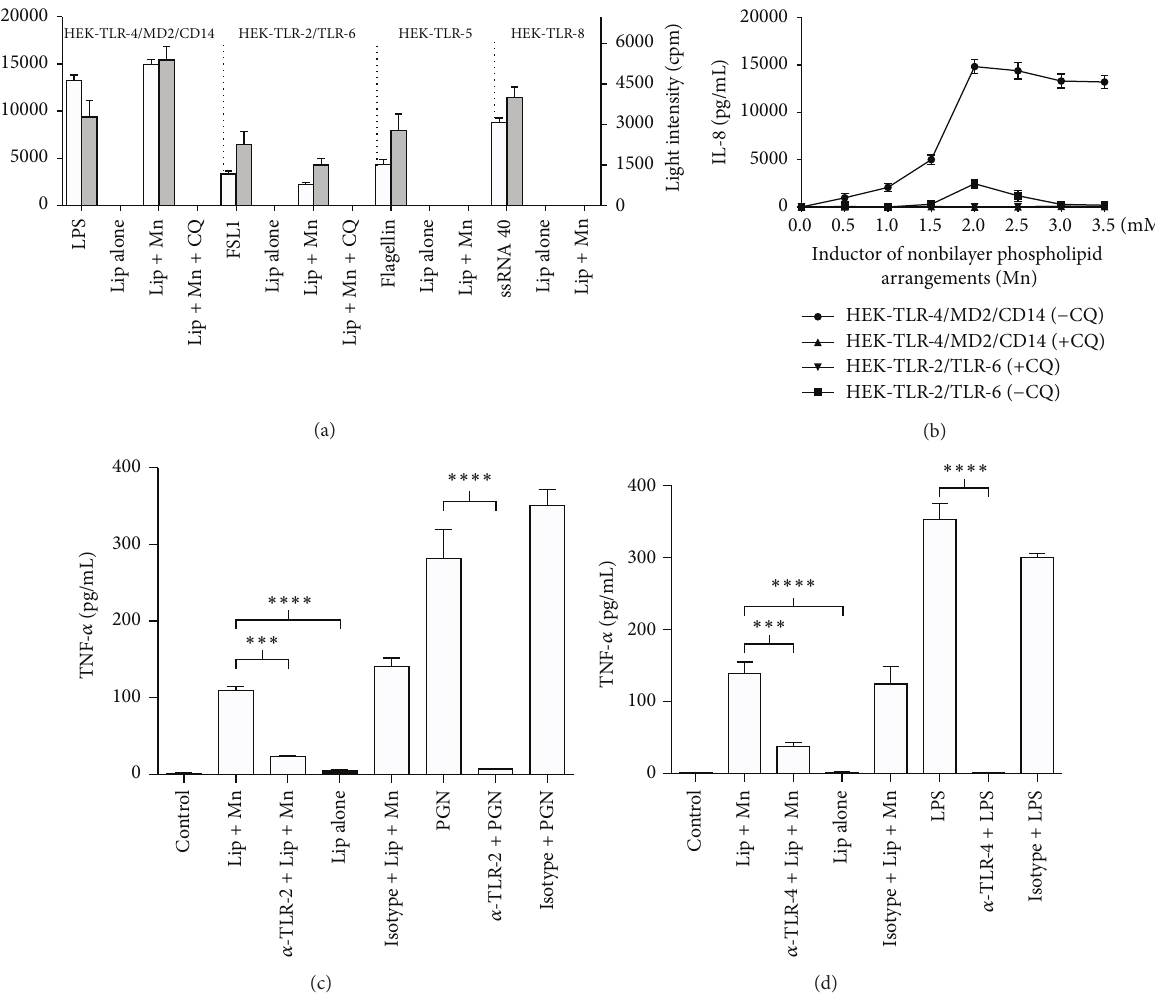
Figure 2: Liposomes with nonbilayer phospholipid arrangements induce TLR-2/6 and TLR-4 signaling in TLR-expressing HEK cells. (a) HEK-TLR-4/MD2/CD14, HEK-TLR-2/TLR-6, HEK-TLR-5, and HEK-TLR-8 cells were stimulated for 24h at 37 ∘ C with 10 𝜇 L of egg-yolk phosphatidylcholine/egg-yolk phosphatidic acid (2 :1) liposomes (50nmol phosphatidic acid in 50 𝜇 L TS buffer) alone or bearing nonbilayer phospholipid arrangements induced with 2mMMnCl 2 . As positive controls, cells were stimulated with their TLR agonist: 100ng/mL LPS, 1 𝜇 g/mL FSL1, 1 𝜇 g/mL bacterial flagellin, or2.5 𝜇 g/mLssRNA40, respectively. As negative controls, cells were stimulated with liposomes alone or bearing nonbilayer phospholipid arrangements + 0.1mM chloroquine (CQ). IL-8 levels and NF- 𝜅 B activation were measured 24h after stimulation. (b) HEK-TLR-4/MD2/CD14 and HEK-TLR-2/TLR-6 cells were stimulated with nonbilayer phospholipid arrangements induced with different MnCl 2 concentrations with (+CQ) or ( − CQ) 0.1mM chloroquine. IL-8 levels were measured 24h after stimulation. Histograms and graphs represent the mean ± SD of three independent experiments. (c, d) TLR-2 and TLR-4 of bone marrow-derived macrophages (BMDM) were analyzed. (c) 4 × 10 4 BMDM were stimulated with liposomes alone or bearing Mn 2+ -induced nonbilayer phospholipid arrangements (as in a). Where indicated, 10 𝜇 g/mL of anti-TLR-2 or isotype control (IgG1, 𝜅 ) was added 2h before liposomes addition. PGN (1 𝜇 g/mL) was the positive control. After 24 h at 37 ∘ C, TNF- 𝛼 levels were determined. (d) 3 × 10 3 BMDM were stimulated with 20 𝜇 L of liposomes (as in a). Where indicated, 20 𝜇 g/mL of anti-TLR-4 or isotype control (IgG2a, 𝜅 ) was added 2 h before liposomes addition. LPS (10ng/mL) was the positive control. TNF- 𝛼 levels were determined as in (c). Histograms represent the mean ± SD of three independent experiments. Data were analyzed with one-way ANOVA and Tukey’s multiple comparisons test. ∗∗∗∗ 𝑝 ≤ 0.0001 , ∗∗∗ 𝑝 ≤ 0.001